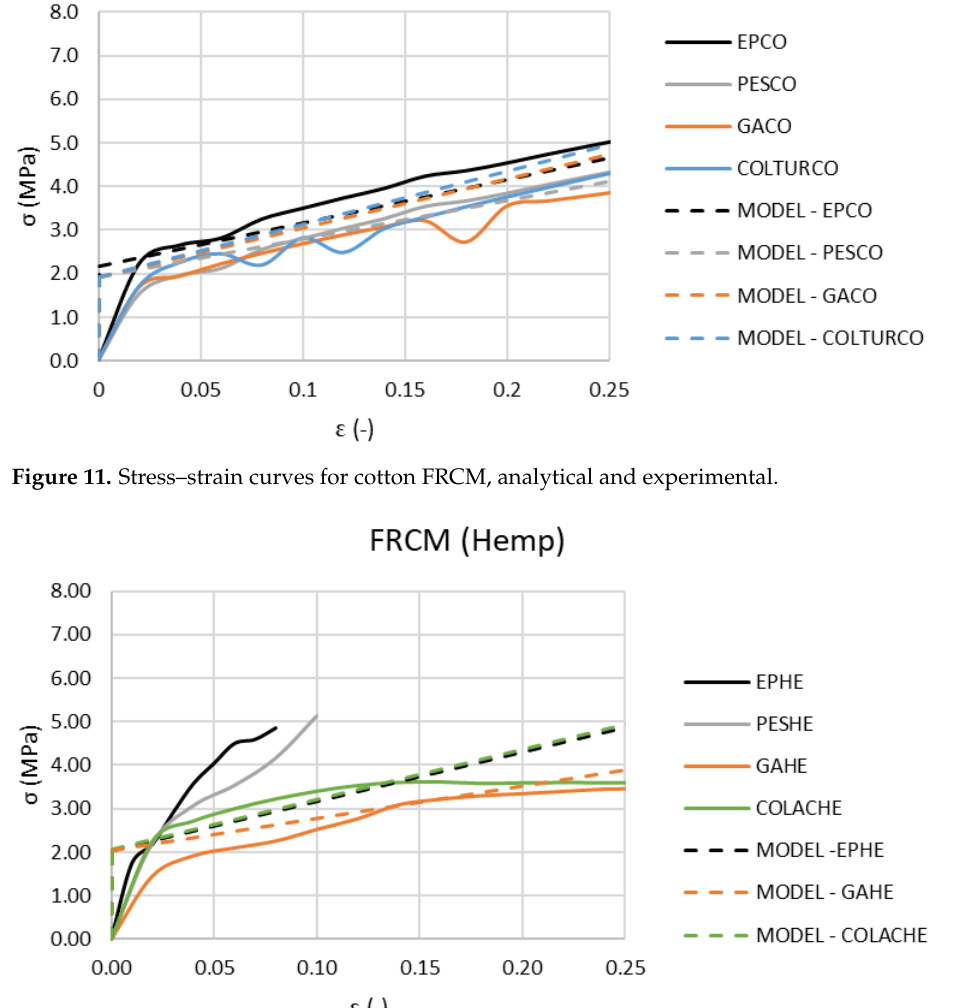
Figure 12. Stress–strain curves for hemp FRCM, analytical and Figure 12. Stress – strain curves for hemp FRCM, analytical and experimental.